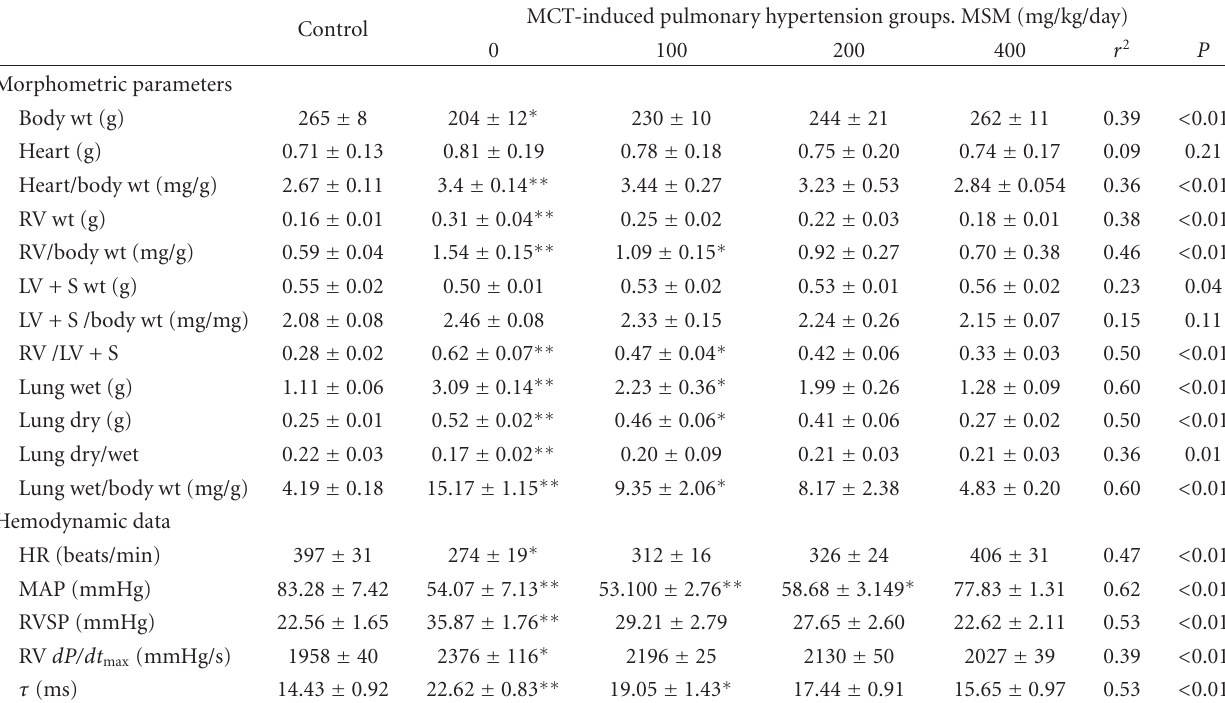
Table 1: Morphometric parameters and hemodynamic data of control and monocrotaline-injected male rats.